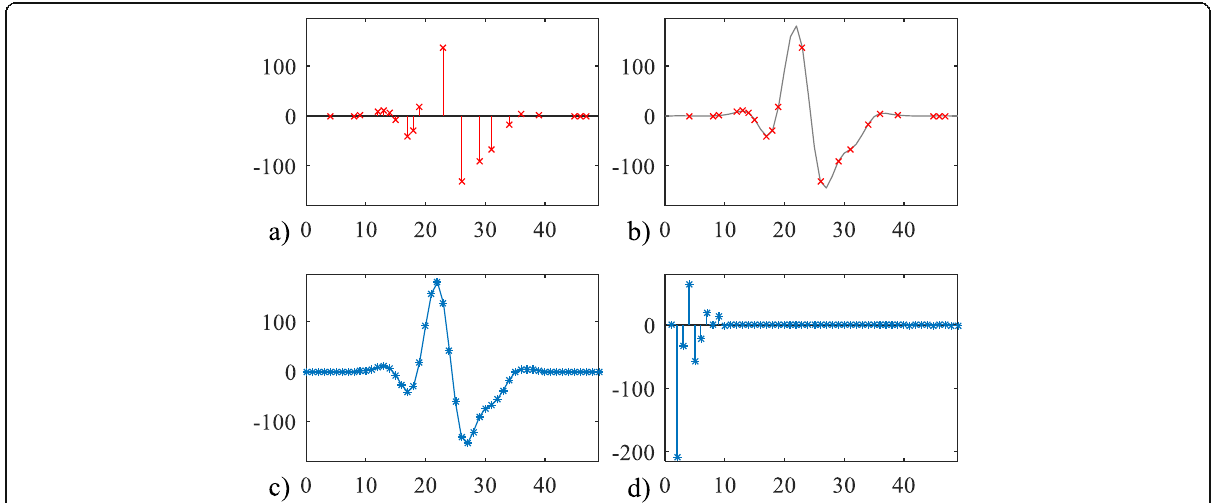
Fig. 11 a 20 available samples (out of 50) of QRS signal, b original QRS signal (full-length signal consisting of 50 samples) with available samples marked in red, c reconstructed (full length) QRS signal, d Hermite transform of the reconstructed